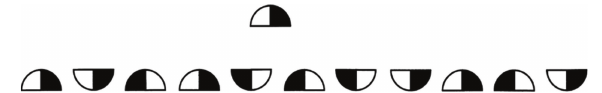
Figure 1: Single row of the nonverbal geriatric concentration test (AKT). Subjects had to mark 20 symbols equivalent to the one at the top in five rows of 55 similar looking patterns within a maximum time limit of 30 s. After an initial training session, three consecutive sessions were run. Needed times for each session were averaged for evaluating individual